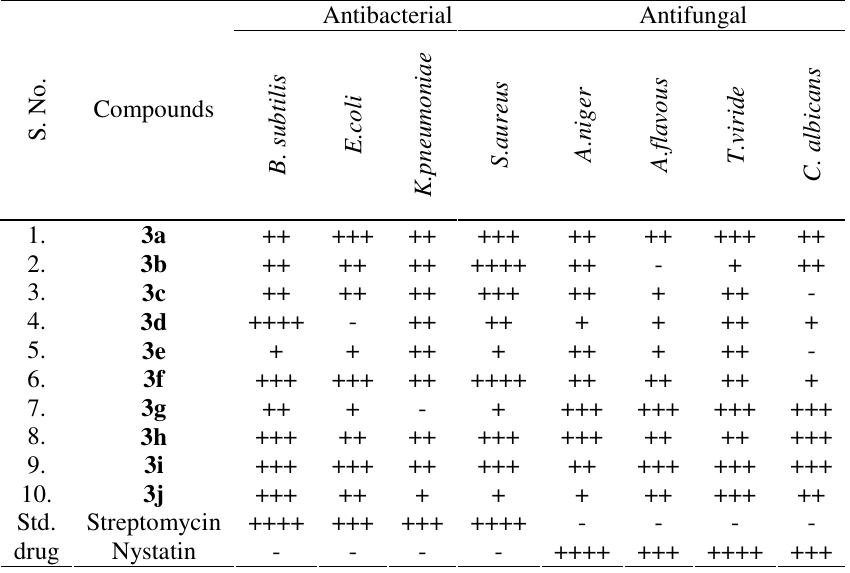
Table 2. Antimicrobial data of compounds 3a-j.